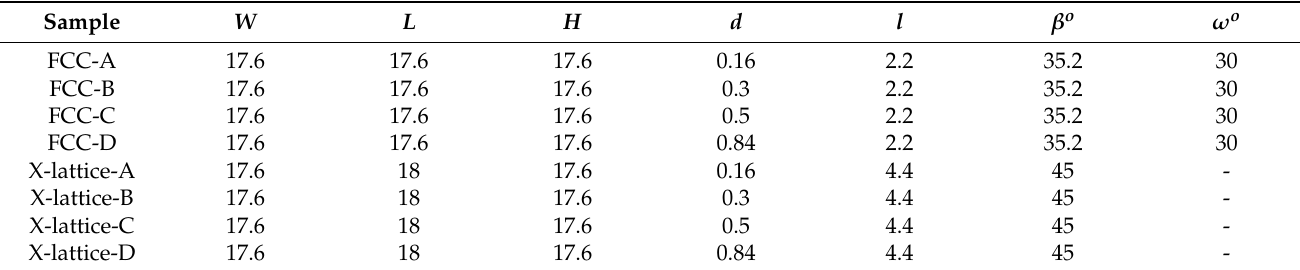
Table 1. Configuration parameters of different lattice structures (mm).